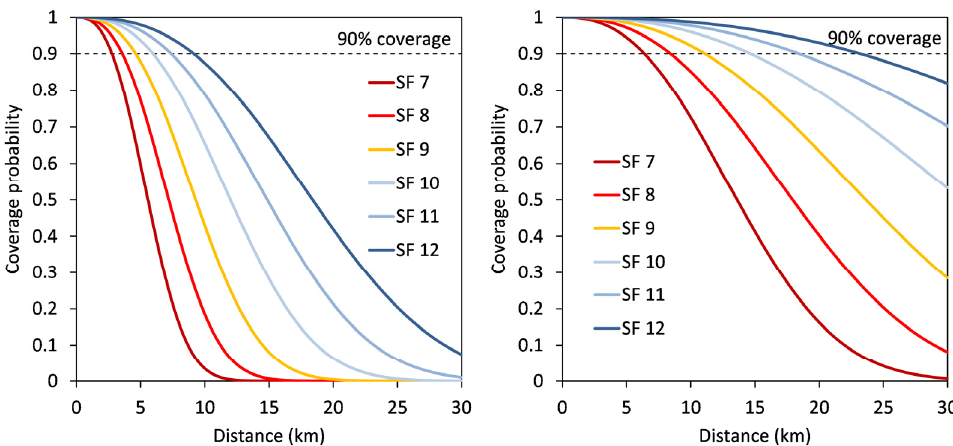
Figure 5. Coverage probabilities for path loss exponents 2.5 ( left ) and 2.7 ( right ) using different spreading factors on a carrier frequency of 868.5 MHz and radio link distances (from 0–30 km). The dashed line depicts the 90% coverage probability.